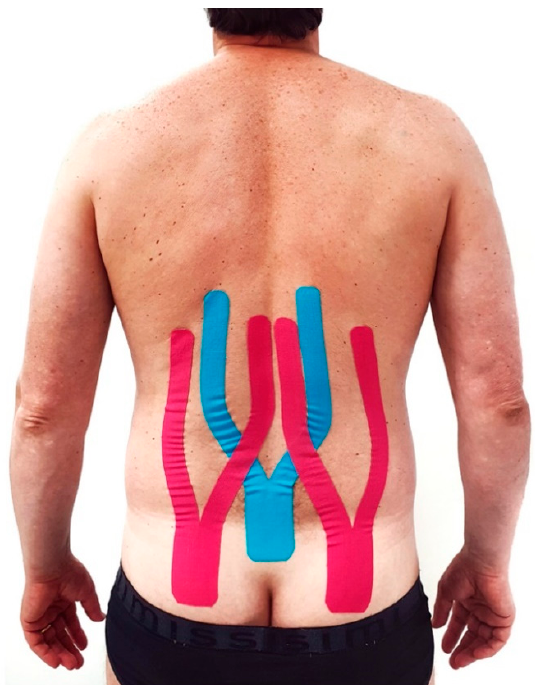
Figure 4. Kinesio taping application in a Y shape. The blue tape is applied over paravertebral chains and the pink tape over the latissimus dorsi and sacrospinalis group of muscles.